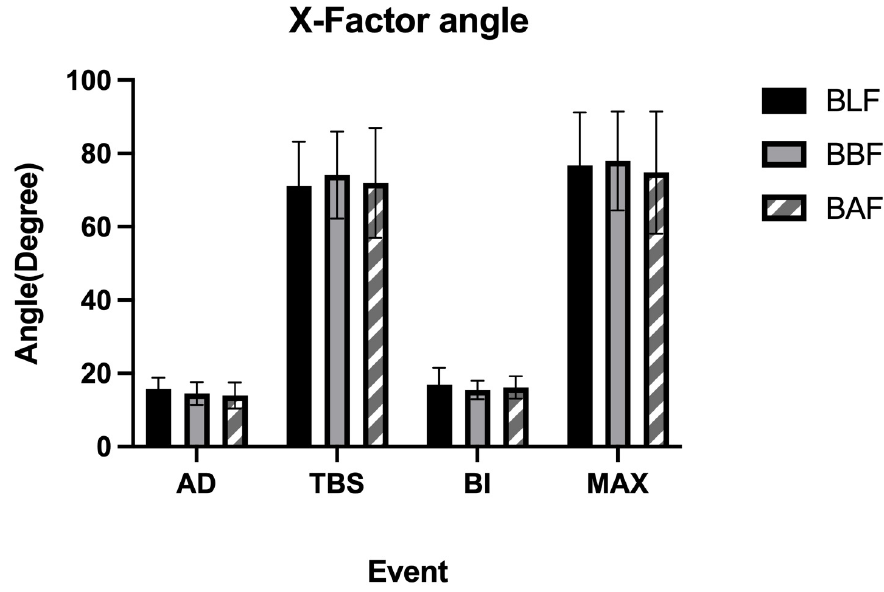
Figure 6. X-factor values at critical events. Comparisons of BLF, BBF, and BAF during AD, TBS, BI, and MAX.